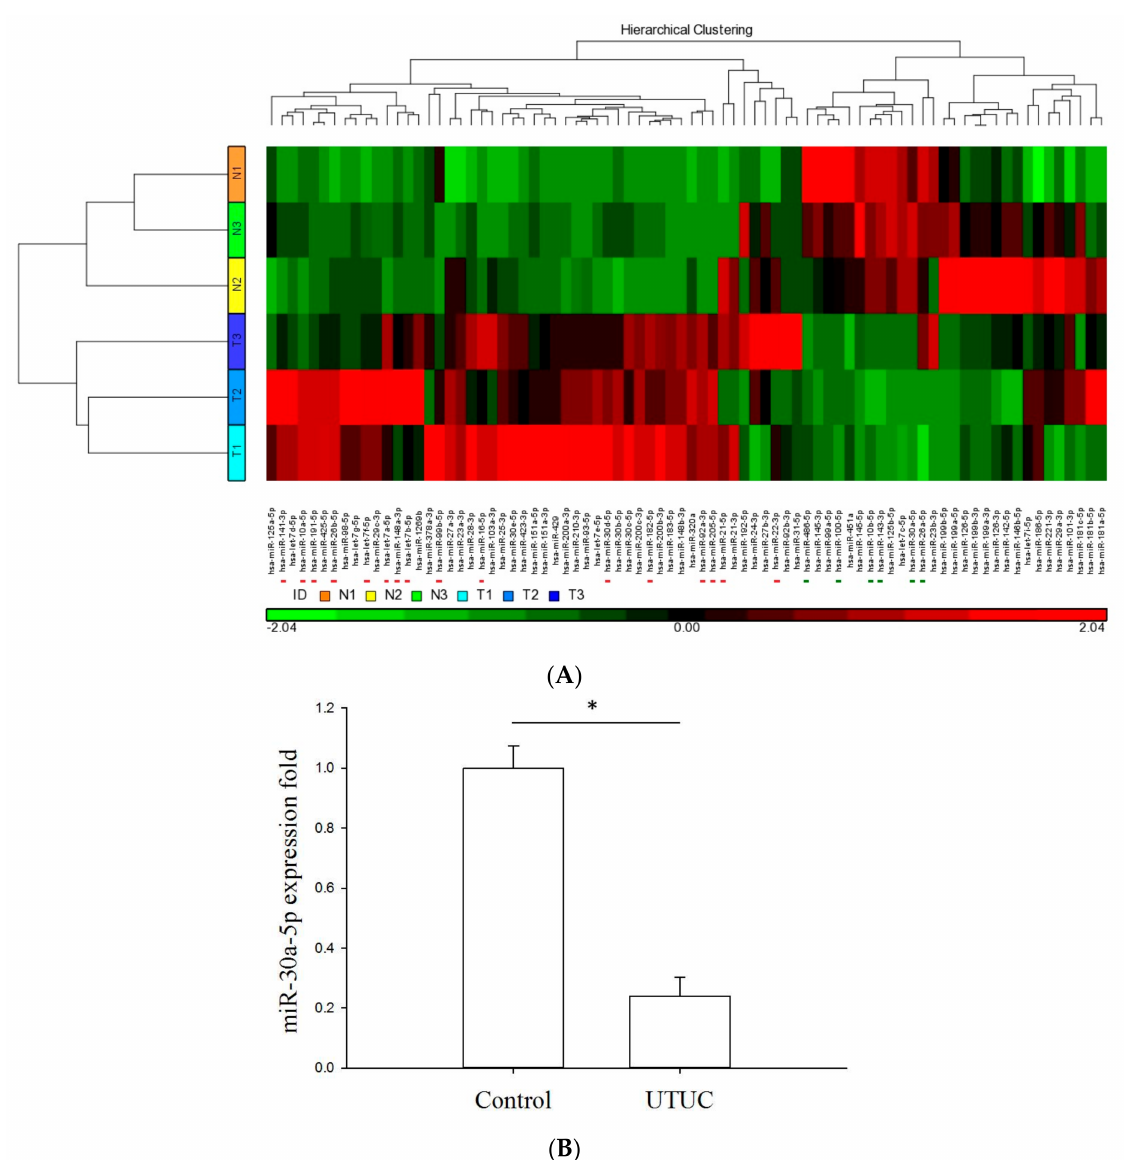
Figure 1. Expression profiles of miRNAs in human UTUC tumor and non-tumor samples. Three tumor (T1–T3; light blue to navy blue) and three adjacent normal tissues (N1–N3; orange-yellow-green) were subjected to RNA extraction and NGS-miRNA sequencing through the Illumina MiSeq platform. ( A ) Heat-map clustering analysis was conducted to examine the overall miRNA expression profiles among samples. A line scatterplot was used to present miRNA expression profiles; ( B ) Downregulation of miR-30a-5p in UTUC tumor tissues ( n = 22) compared with adjacent normal controls ( n = 14) by RT-qPCR analysis. The asterisk denotes p < 0.001 using an unpaired t